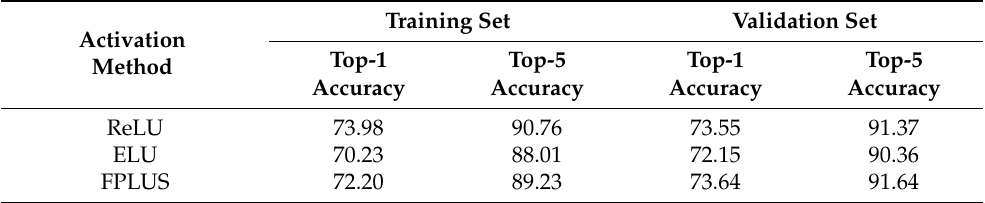
Table 9. Top-1 and top-5 accuracy rates (%) of each activation method applied on ResNet-101 for ILSVRC2012, grouped by training set and validation